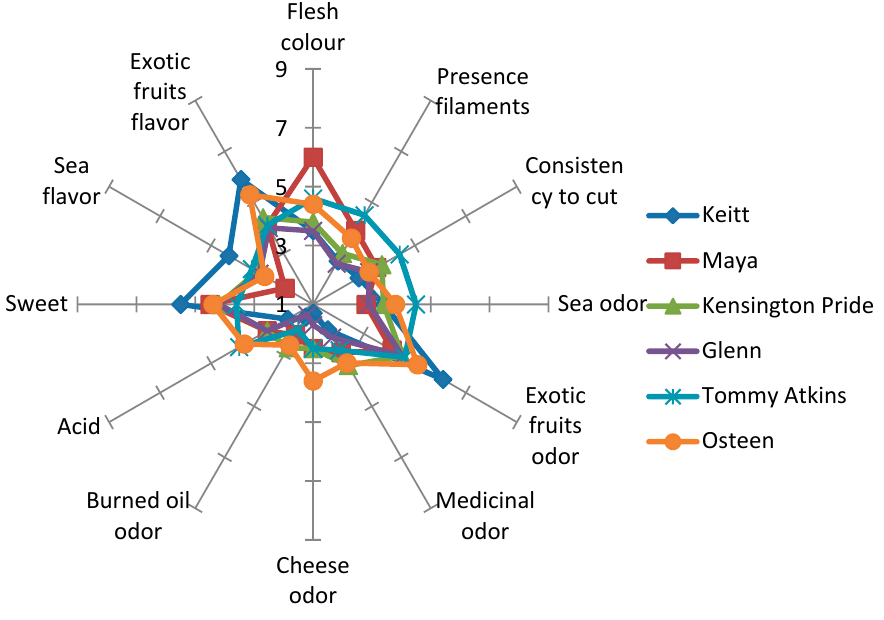
Figure 1. Sensory profiles of the six observed mango cultivars as evaluated by a trained panel. Data are mean values ± SD ( n =